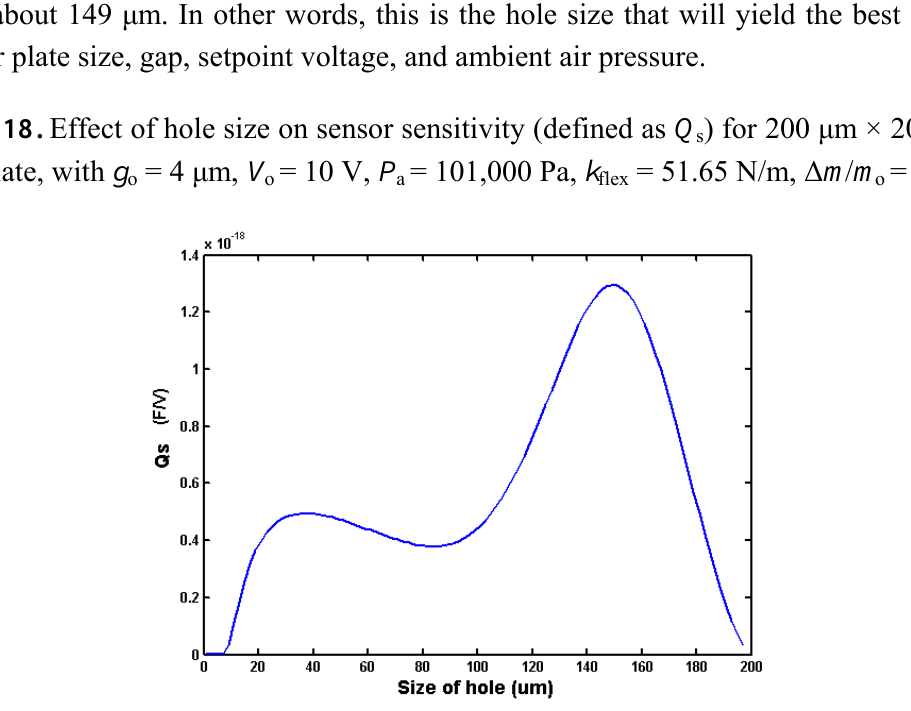
Figure 18. Effect of hole size on sensor sensitivity (defined as Q